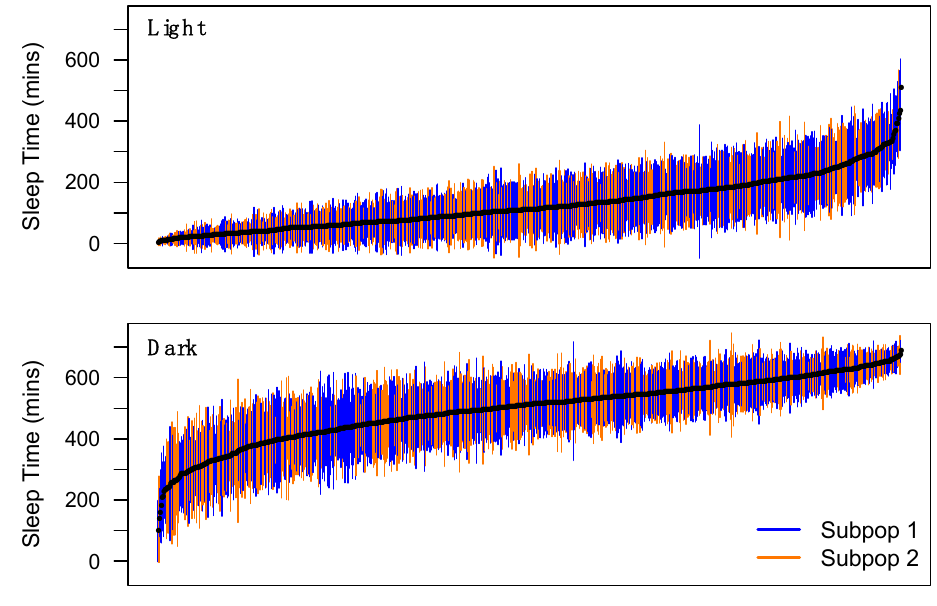
Figure 1. Distribution of sleep time across DSPRF1 genotypes. Mean sleep time ( +/ − 1SD) during the light and dark period for each of 787 trans-heterozygous virgin female DSPRF1 genotypes. Genotypes derived from subpopulation 1 (progeny of crosses between pA1 × pB2 Recombinant Inbred Lines (RILs)) and subpopulation 2 (progeny of crosses between pA2 × pB1 RILs) are highlighted in di ff erent colors. Since the subpopulations di ff er slightly in their founder composition, they can exhibit average di ff erences in phenotype. For instance, the subpopulations di ff er in light-phase sleep time (Welch’s t -test, P < 0.001), but not in dark-phase sleep time ( P = 0.97). We corrected for subpopulation-to-subpopulation e ff ects during QTL mapping for all sleep / activity phenotypes.